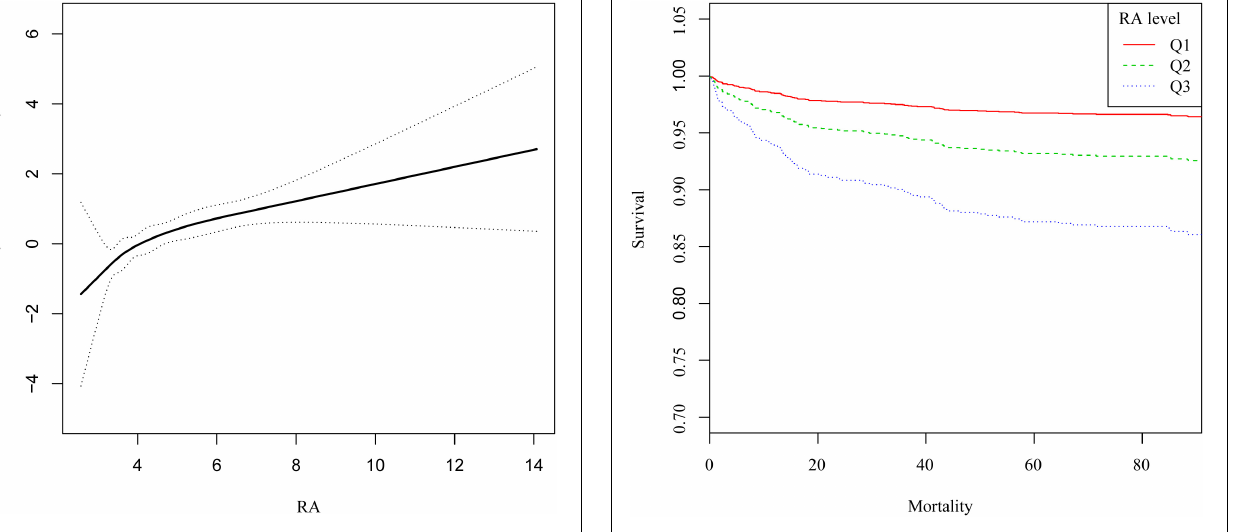
FIGURE 3 | Kaplan–Meier survival curve of 90-day all-cause mortality in patients after PCI. Q1, RA < 3.7 ml/g; Q2, RA was 3.7–4.5 ml/g; Q3, RA > 4.5